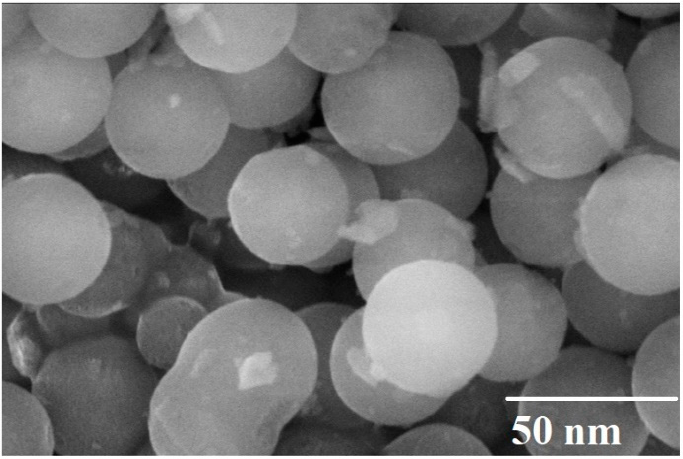
Figure 2. FE ‐ SEM image of Cu ‐ doped, plant ‐ extracted CoFe 2 O 4 nanoparticles at x = 0.6. Figure 2. FE-SEM image of Cu-doped, plant-extracted CoFe 2 O 4 nanoparticles at x =